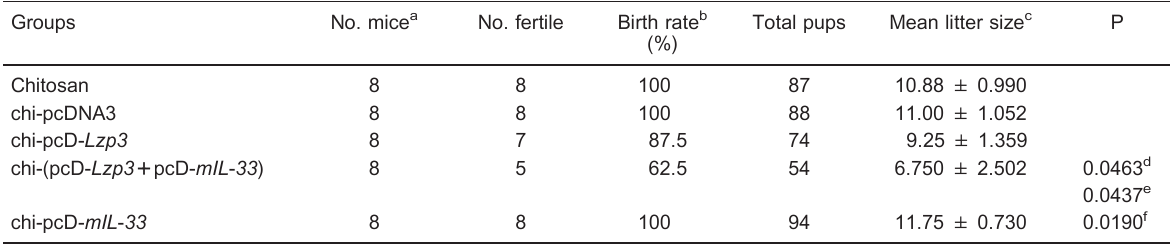
Data are reported as means±SE. a Female ICR mice were immunized with chitosan or different chitosan-DNA vaccines at 2-week intervals. Mice were mated on day 7 after the final immunization. b Birth rate was calculated by the fertile numbers divided by the number of total mated females in each group. c Mean litter size was calculated by the total number of pups of each group divided by the number of total mated females in each group. d P , 0.05, chi-(pcD- Lzp3 +pcD- mIL-33 ) compared to chitosan. e P , 0.05, chi-(pcD-